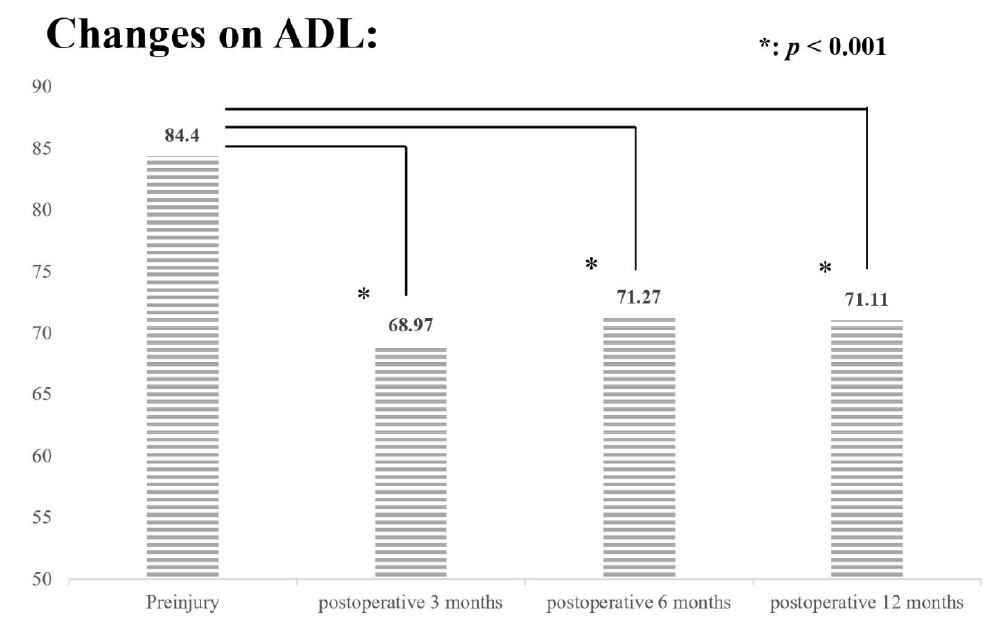
Figure 1. Consecutive QoL (EQ-5D) measurements at preinjury, 3, 6, and 12 months after hip frac- ture repair surgery. *: p < 0.001.